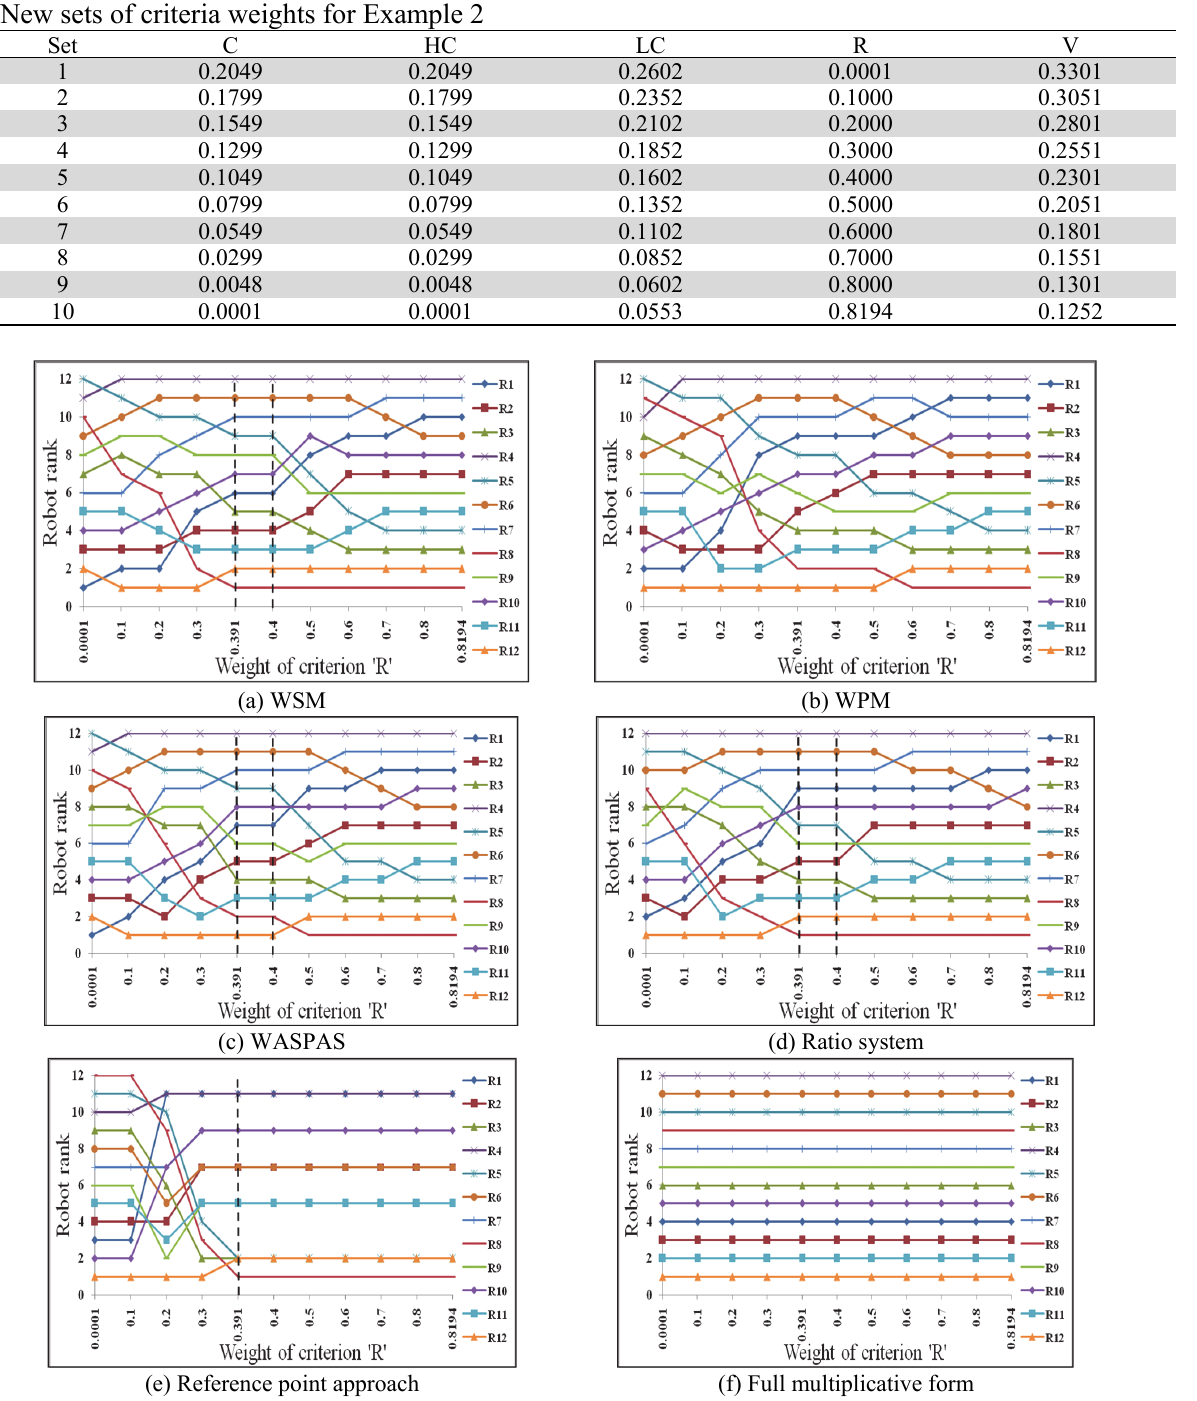
Fig. 4. Results of single dimensional weight sensitivity analysis for Example